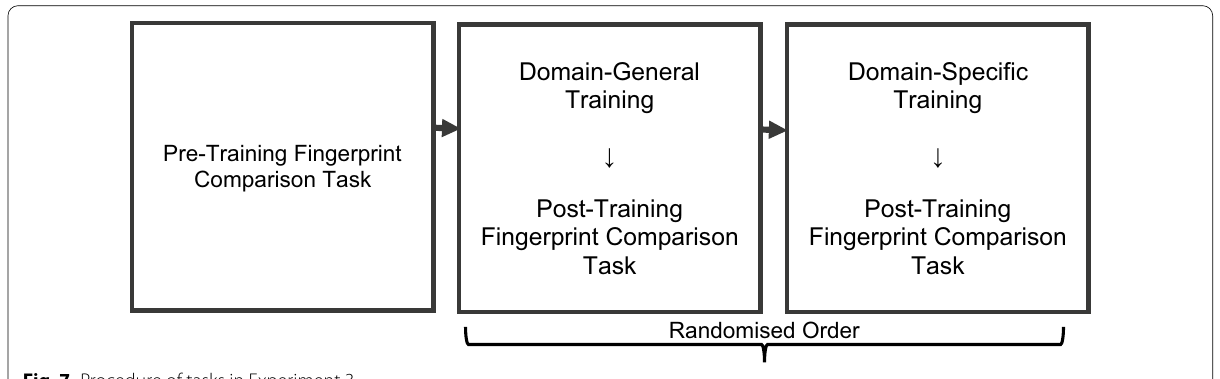
Fig. 7 Procedure of tasks in Experiment